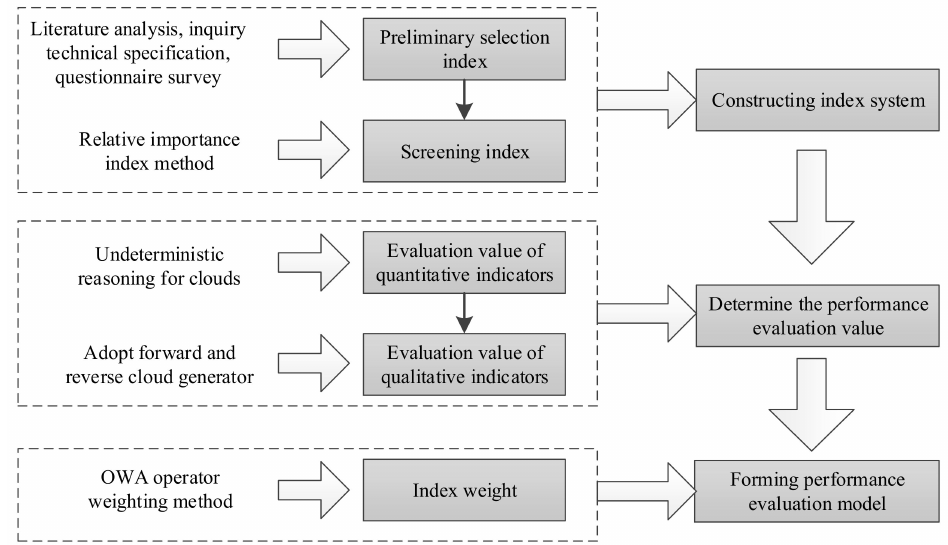
Figure 2. The framework of the research method.